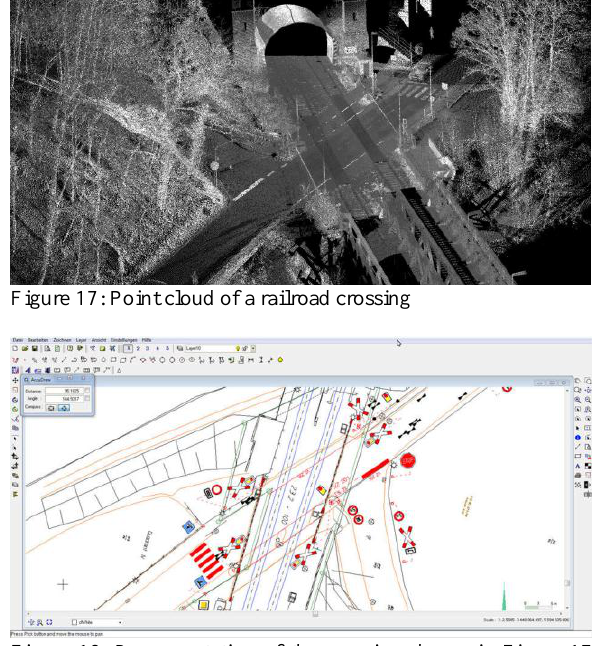
Figure 18: Documentation of the crossing shown in Figure 17 created with BÜ-Master